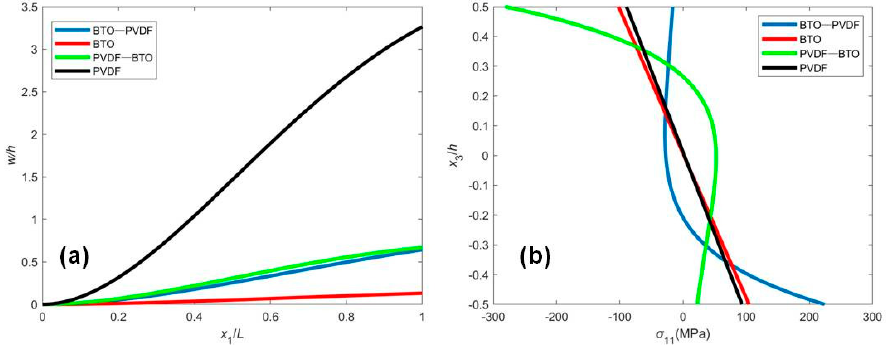
Figure 4. ( a ) The normalized deflection w / h and ( b ) stress distribution σ 11 of FGM sensors subjected to the mechanical loading q = 0.01 nN / nm